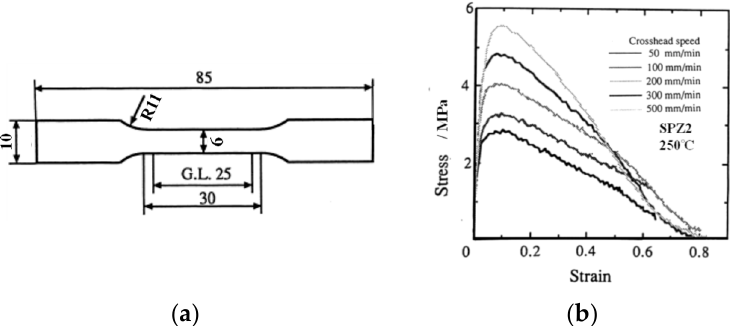
Figure 1. Tensile test of the used material ( a ) specimen (unit: mm) and ( b ) stress–strain curves at different tensile speeds. Table 1. Mechanical properties of used material.